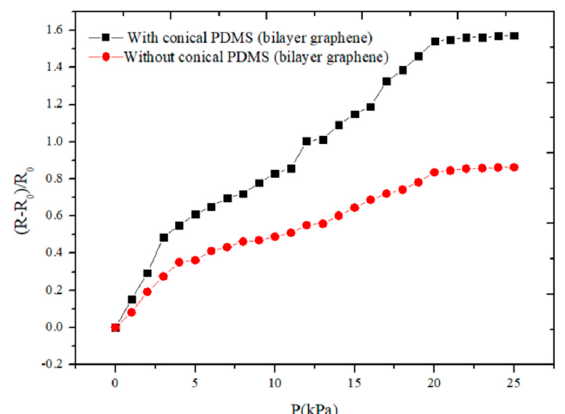
Figure 8. The sensitivity curves of the sensor with and without conical microstructure PDMS.